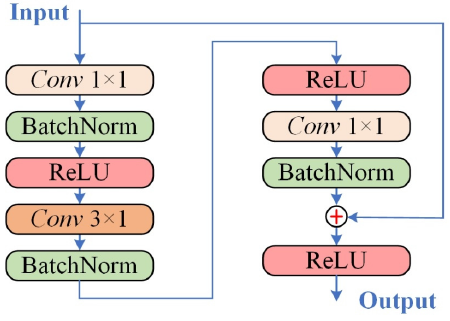
Figure 2. The Res-block applied in the proposed network architecture.